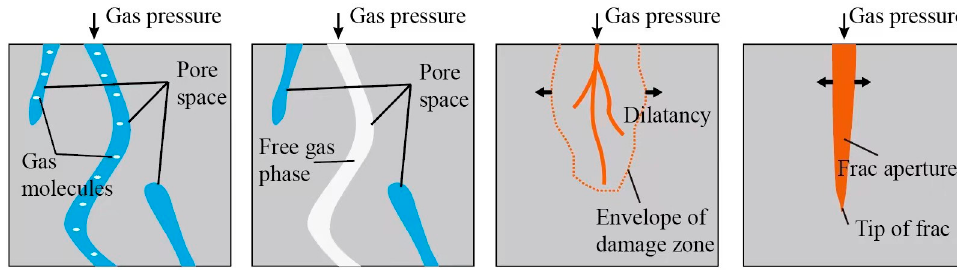
Figure 1. Four mechanisms of gas transport and breakthrough in low-permeability